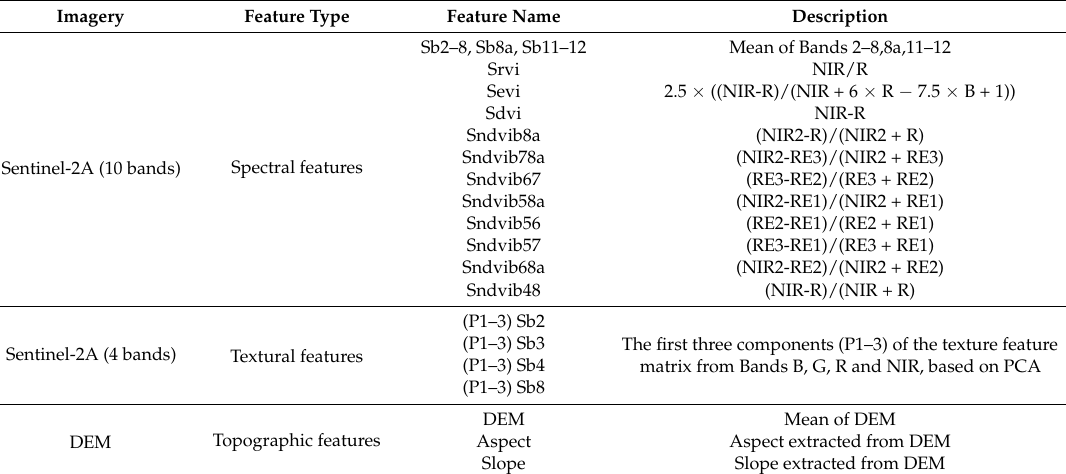
Table 6. Description of object features for the Level-2